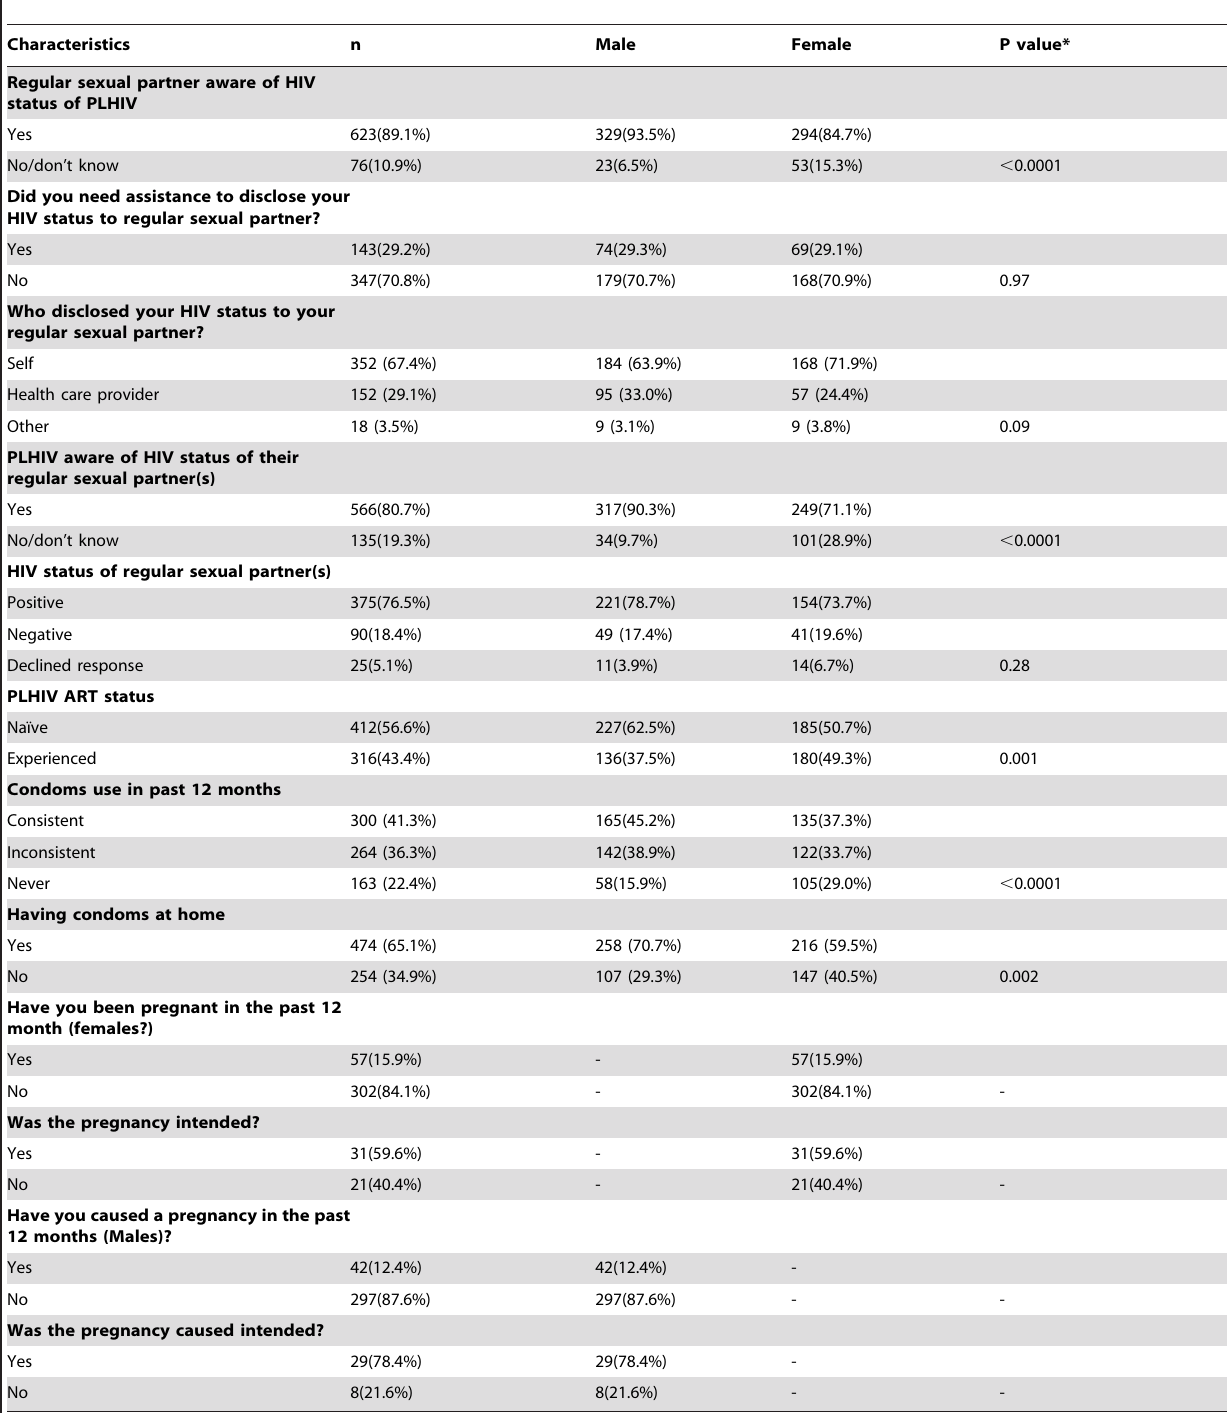
Table 2. Sexual behaviors, disclosure and ART status among the sexually active.